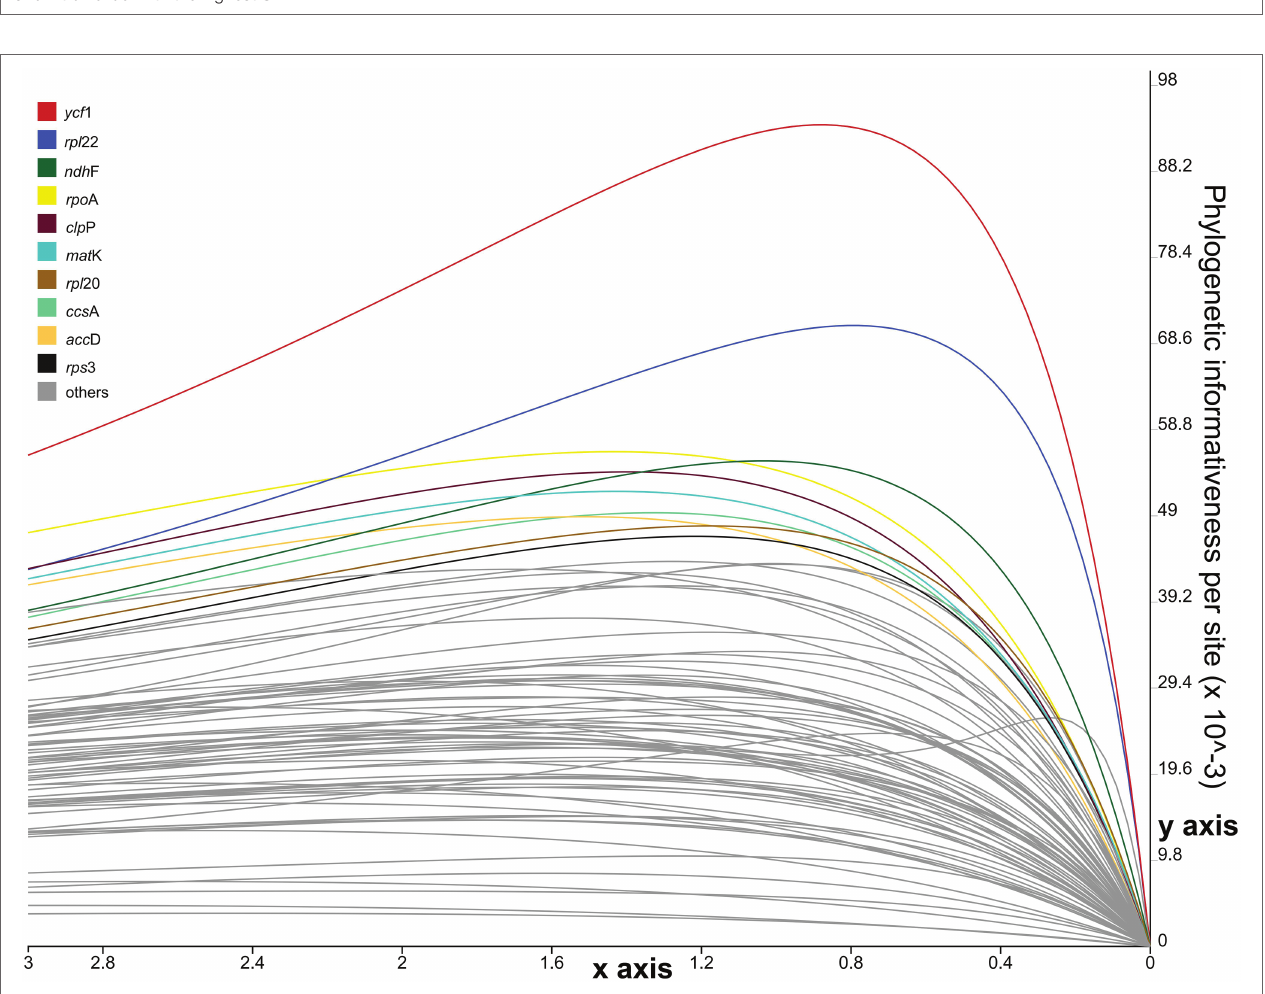
FIGURE 5 | Sequence variability (SV) comparisons of the 85 syntenic intergenic and intronic loci in 22 Euphorbia plastome sequences. The blue lines represent the SV (%) of each locus. These syntenic loci are oriented according to their locations in the plastome. Red dots indicate the top 10 most variable syntenic intergenic and intronic loci with the highest SV.